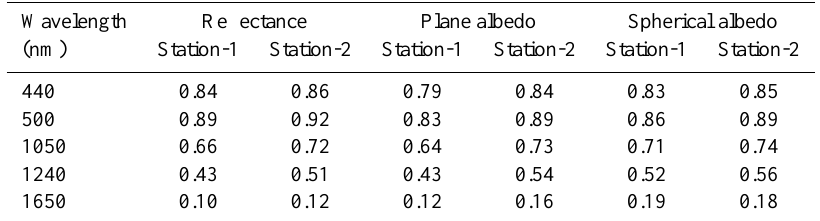
Table 8. Comparison of spectral albedo at station-1 (lower Himalaya) and station-2 (middle Himalaya) with SZA: 46.8 ◦ .